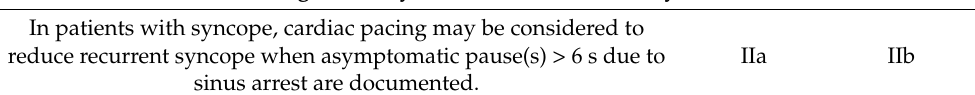
Table 4. Changes in recommendations for cardiac pacing and resynchronization therapy from 2013 to 2021. Cardiac Pacing for Bradycardia and Conduction System